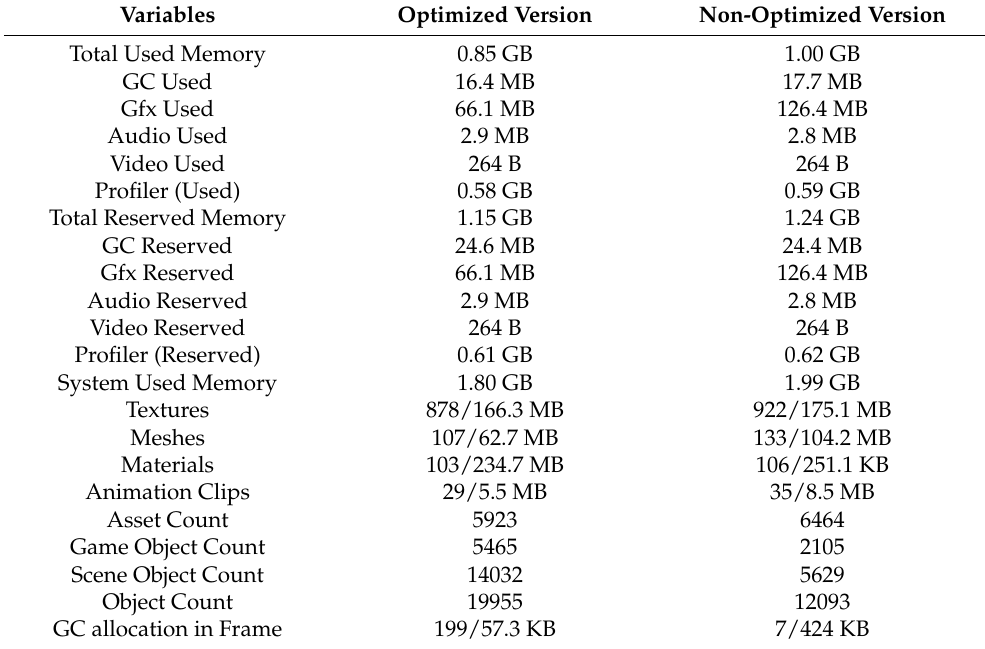
Table 7. Memory data from a frame close to 60 frames per second in the CPU usage